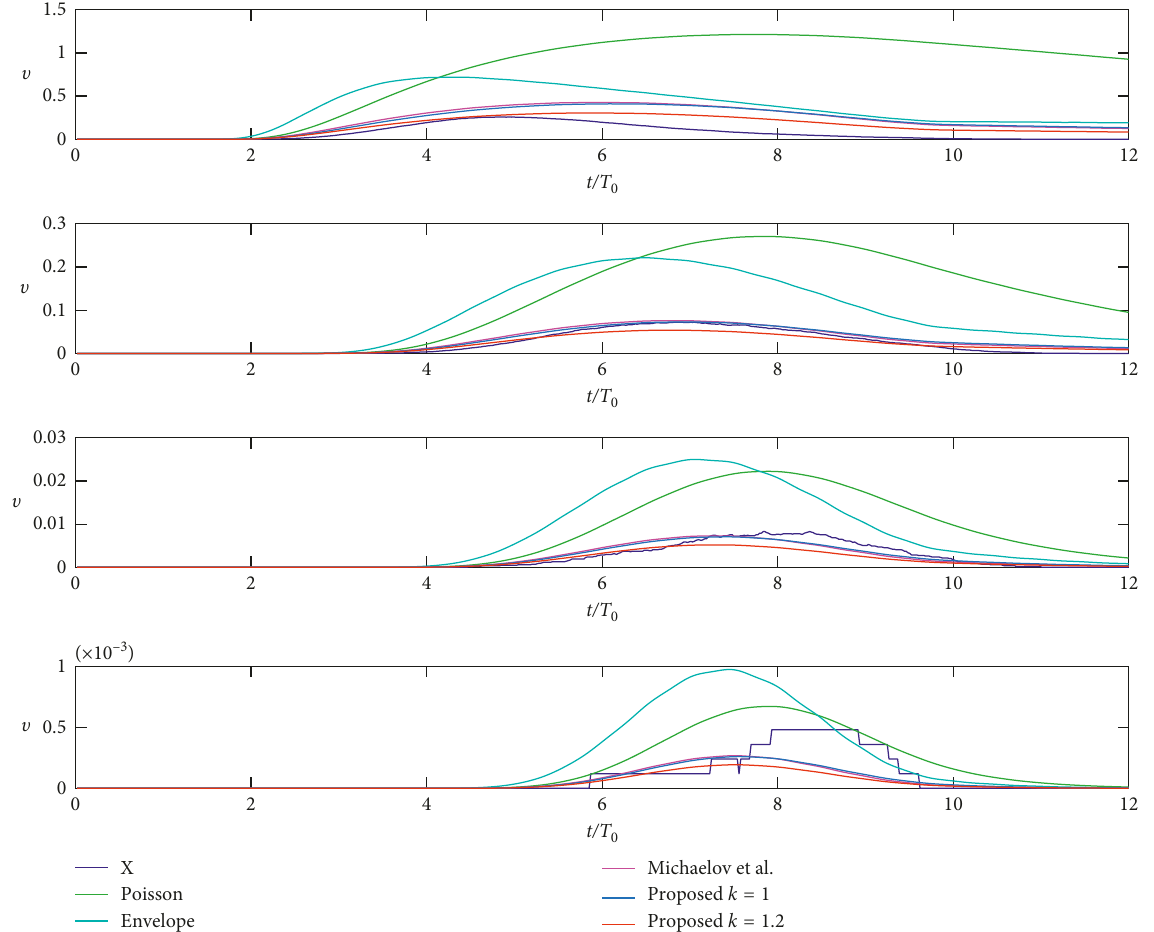
Figure 11: Mean threshold crossing rate for ξ � 0.01 and T